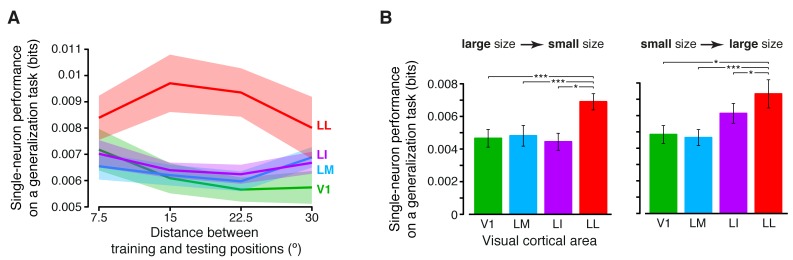
Generalization achieved by single neurons across parametric position and size changes.(A) The curves show the generalization performances of binary decoders (median over the units recorded in each area ± SE) that were trained to discriminate two objects presented at the same position in the visual field, and then were required to discriminate those same objects across increasingly wider positions changes, with respect to the training location (see Materials and methods for details). Differences among the four areas were quantified by a two-way ANOVA with visual area and distance from the training position as factors. The main effects of area (F3,595 = 4.078) and distance (F3,1785 = 2.706) were both significant (p<0.01 and p<0.05, respectively), thus confirming the existence of a gradient in the amount of position tolerance along the areas’ progression and along the distance axis. The interaction term was also significant (p<0.001, F9,1785 = 3.239), indicating that the four decoding performances dropped at a different pace along the distance axis. (B) Discrimination performances of binary decoders (median over the units recorded in each area ± SE) that were required to generalize from a given training size to either a smaller (left) or larger (right) test size (see Materials and methods for details; *p<0.05, **p<0.01, ***p<0.001; 1-tailed U-test, Holm-Bonferroni corrected).